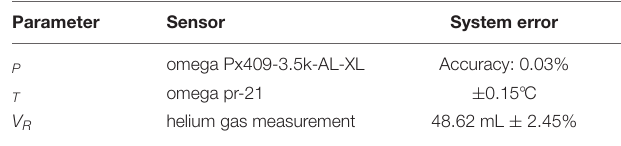
TABLE 4 | The error of the amount of adsorption by any direct parameter